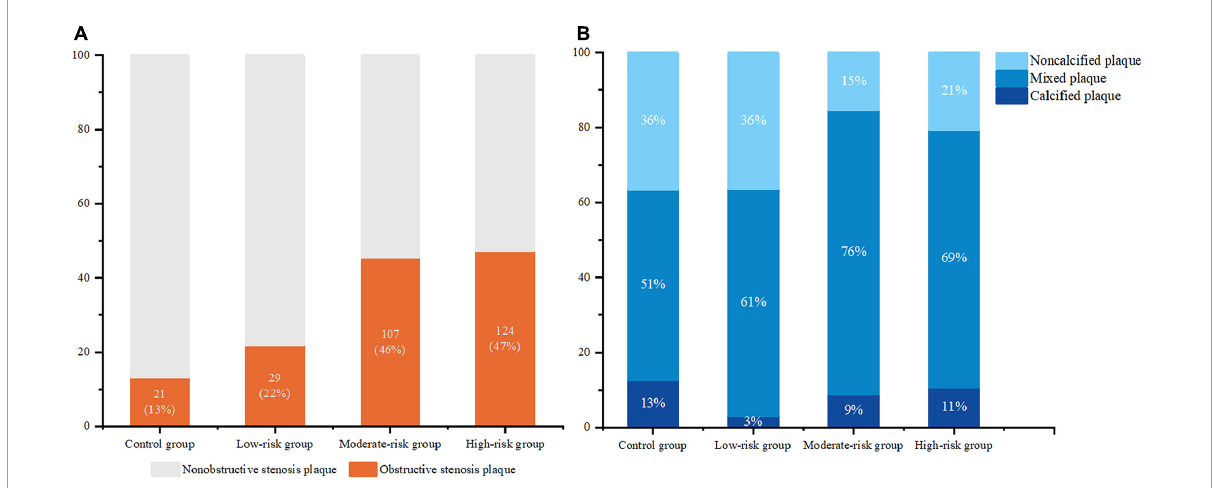
FIGURE3 The proportion of obstructive stenosis plaque (A) and plaque composition proportion (B) in the control group and DM subgroups.